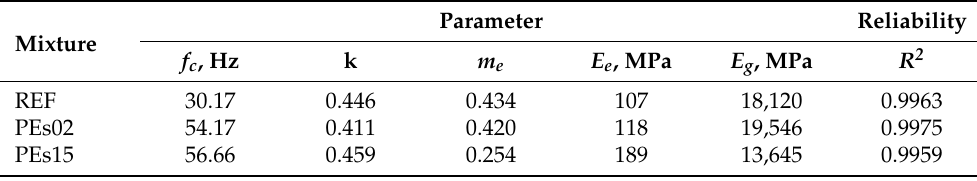
Figure 11. A comparison of the E* master curves (all mixtures). Table 7. The parameters of the NCHRP fitting model for the complex modulus master curves.